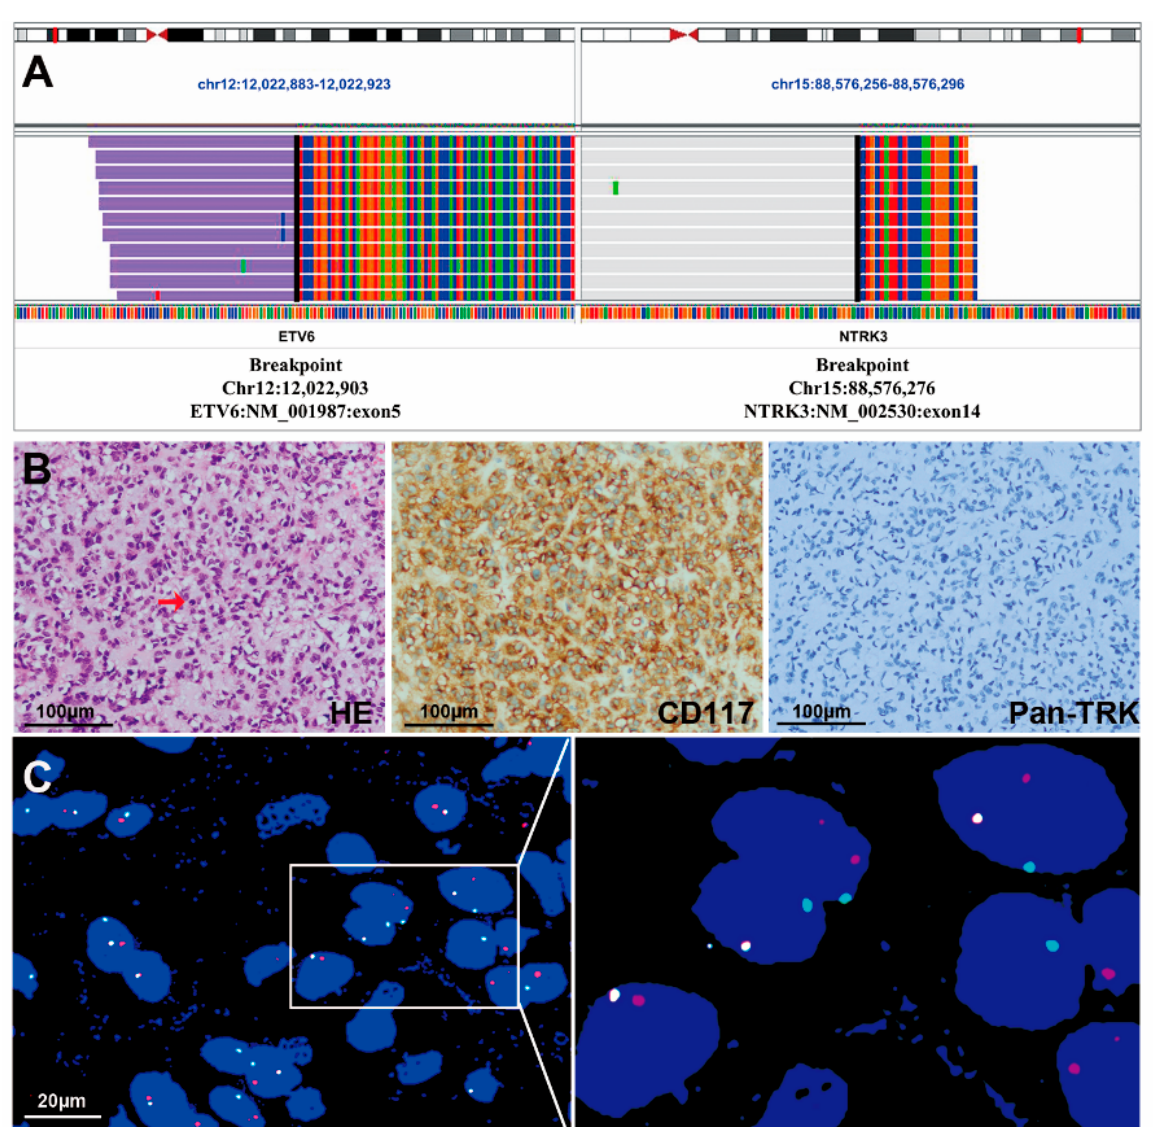
Figure 3. IGV, HE staining, immunohistochemical staining and FISH images of a gastric GIST with an ETV6-NTRK3 fusion (case #2). ( A ) IGV images of NGS indicated an ETV6-NTRK3 fusion. ( B ) HE staining showed that the GIST was composed of epithelioid cells, and the red arrow indicates tumor cell mitosis (HE staining, 400×). The tumor cells were positive for CD117 (400×) and negative for Pan-TRK (400×). Each scale bar is 100µm. ( C ) The FISH assay showed a pair of fused red and green signals using ETV6-NTRK3 fusion probes in almost all tumor cells. Scale bar is 20µm.